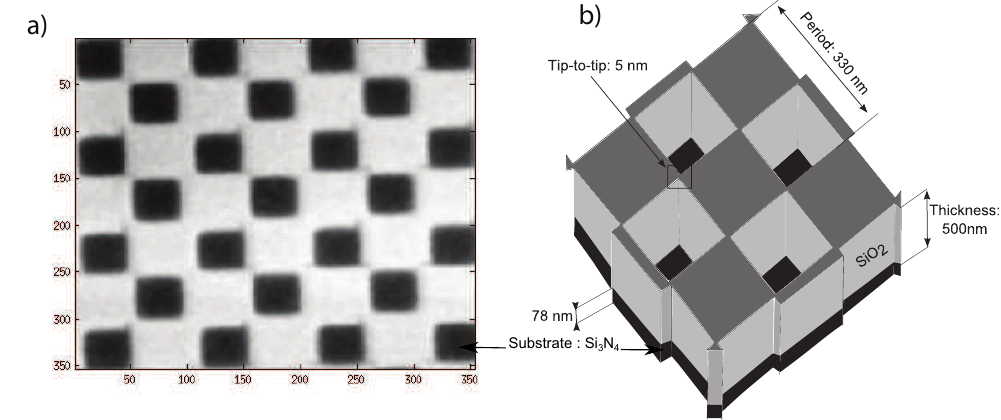
( a ) Scanning electron micrograph of a preliminary chessboard beam-splitter design, with pixel dimensions. ( b ) Final beam-splitter specifications, with the optimized tip-to-tip gap (sketch not to scale).